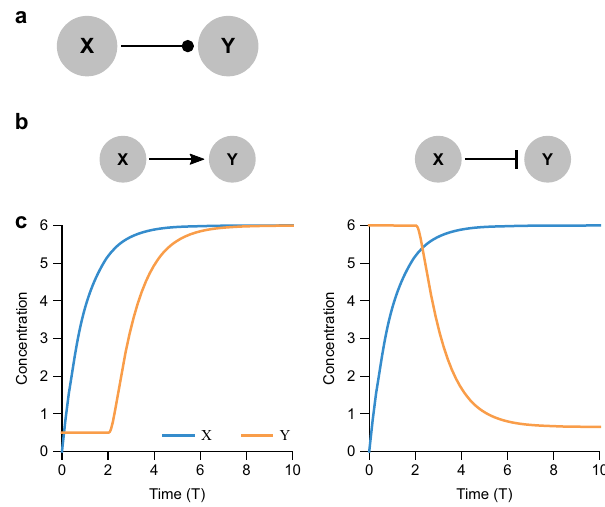
Fig. 2 Direct regulation by activators and inhibitors can be captured using a uni fi ed delay model. a The simplest regulation network consists of a single input X directly regulating a single output Y . We use a dotted arrow to represent either activation or repression, with an implied explicit delay. b Direct activation (left) is represented by a pointed arrow and direct repression (right) by a blunt arrow. c Time response (Eq. (7)) of activated (left) and repressed (right) Y following a rise in X that exponentially approaches a new steady state ( η X = 6) from zero (governed by _ X ð T Þ ¼ η (cid:2) X ð T Þ ). Note that the fi nite value of η X leads to an X